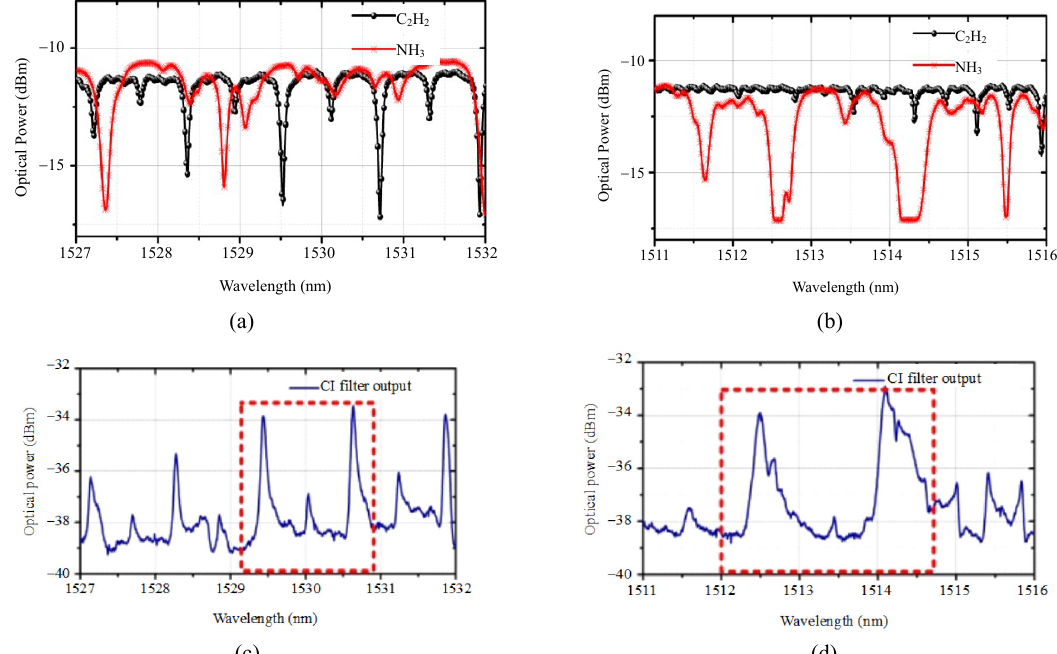
Fig. 3 Analysis of the CI filter: (a) absorption of C 2 H 2 and NH 3 (1 527 nm – 1 532 nm), (b) absorption of C 2 H 2 and NH 3 (1 512 nm – 1 516 nm), (c) CI filter output (1 527 nm – 1532 nm), and (d) CI filter output (1 512 nm – 1 516